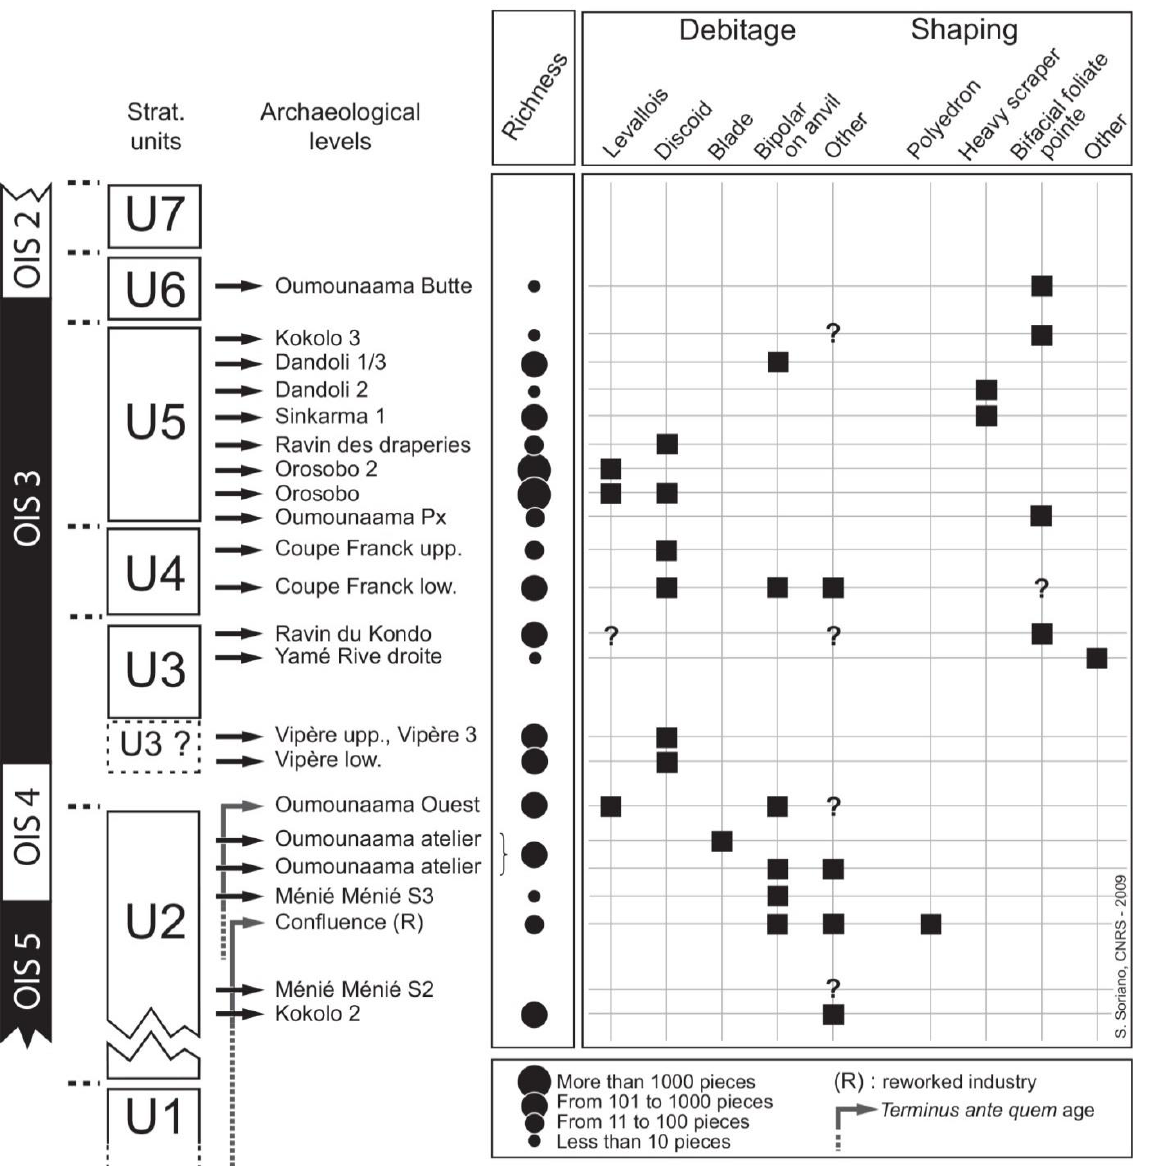
Figure 3. Schematic stratigraphic sequence of Ounjougou (from Soriano et al.